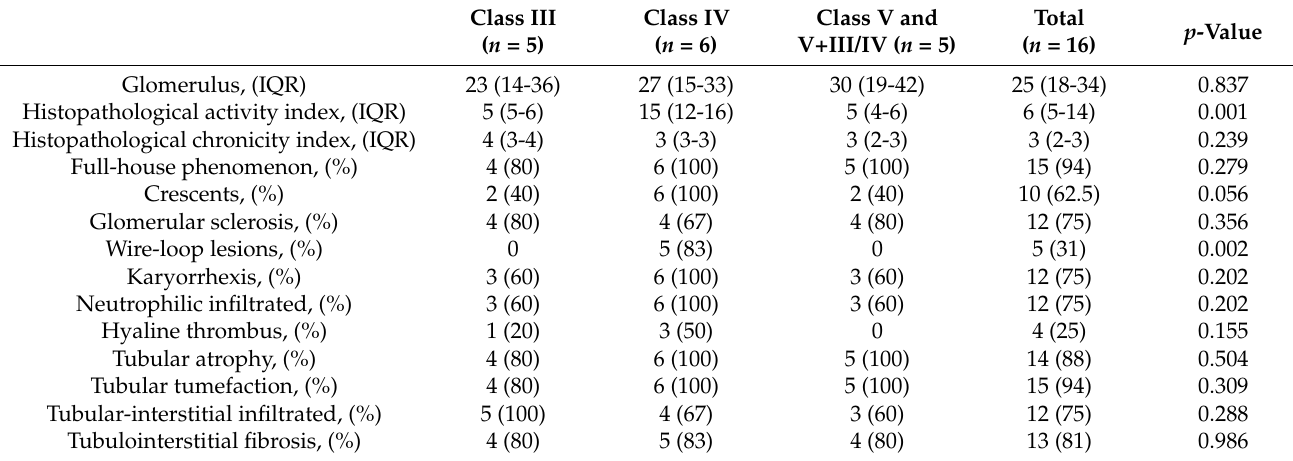
Table 1. Histopathological features of proliferative LN